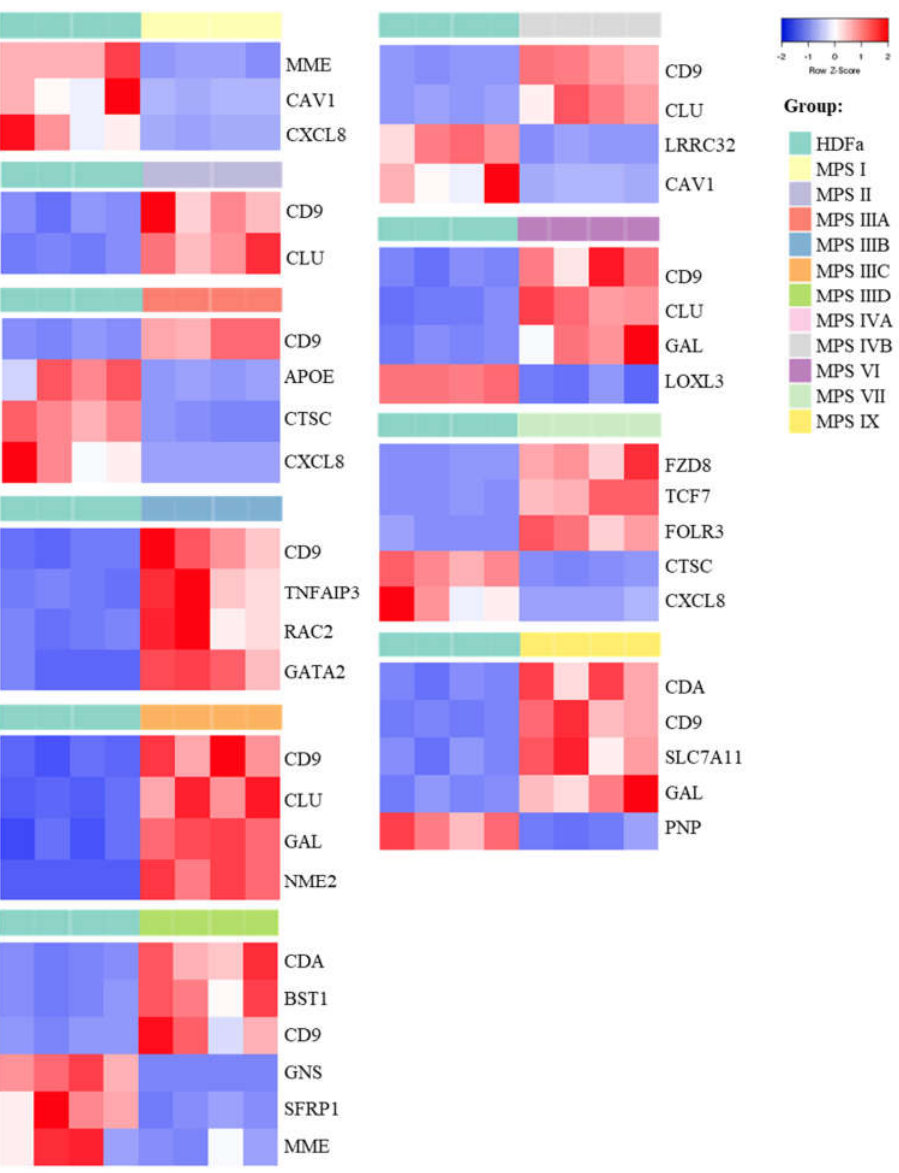
Figure 2. Heat-maps (created with Heatmapper programme) presenting genes particularly up- and down-regulated (FDR < 0.1; p < 0.1; log 2 fold change (FC) > 2.5) in each type of MPS compared to HDF cells taking part in cell activation process.